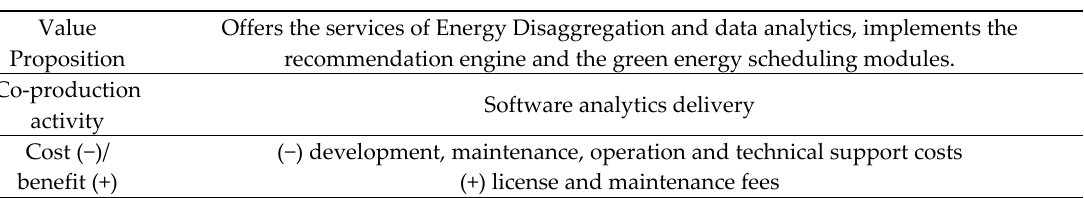
Table 3. Analytics software supplier: Disaggregation, Data Analytics, Green energy scheduling, Recommendation